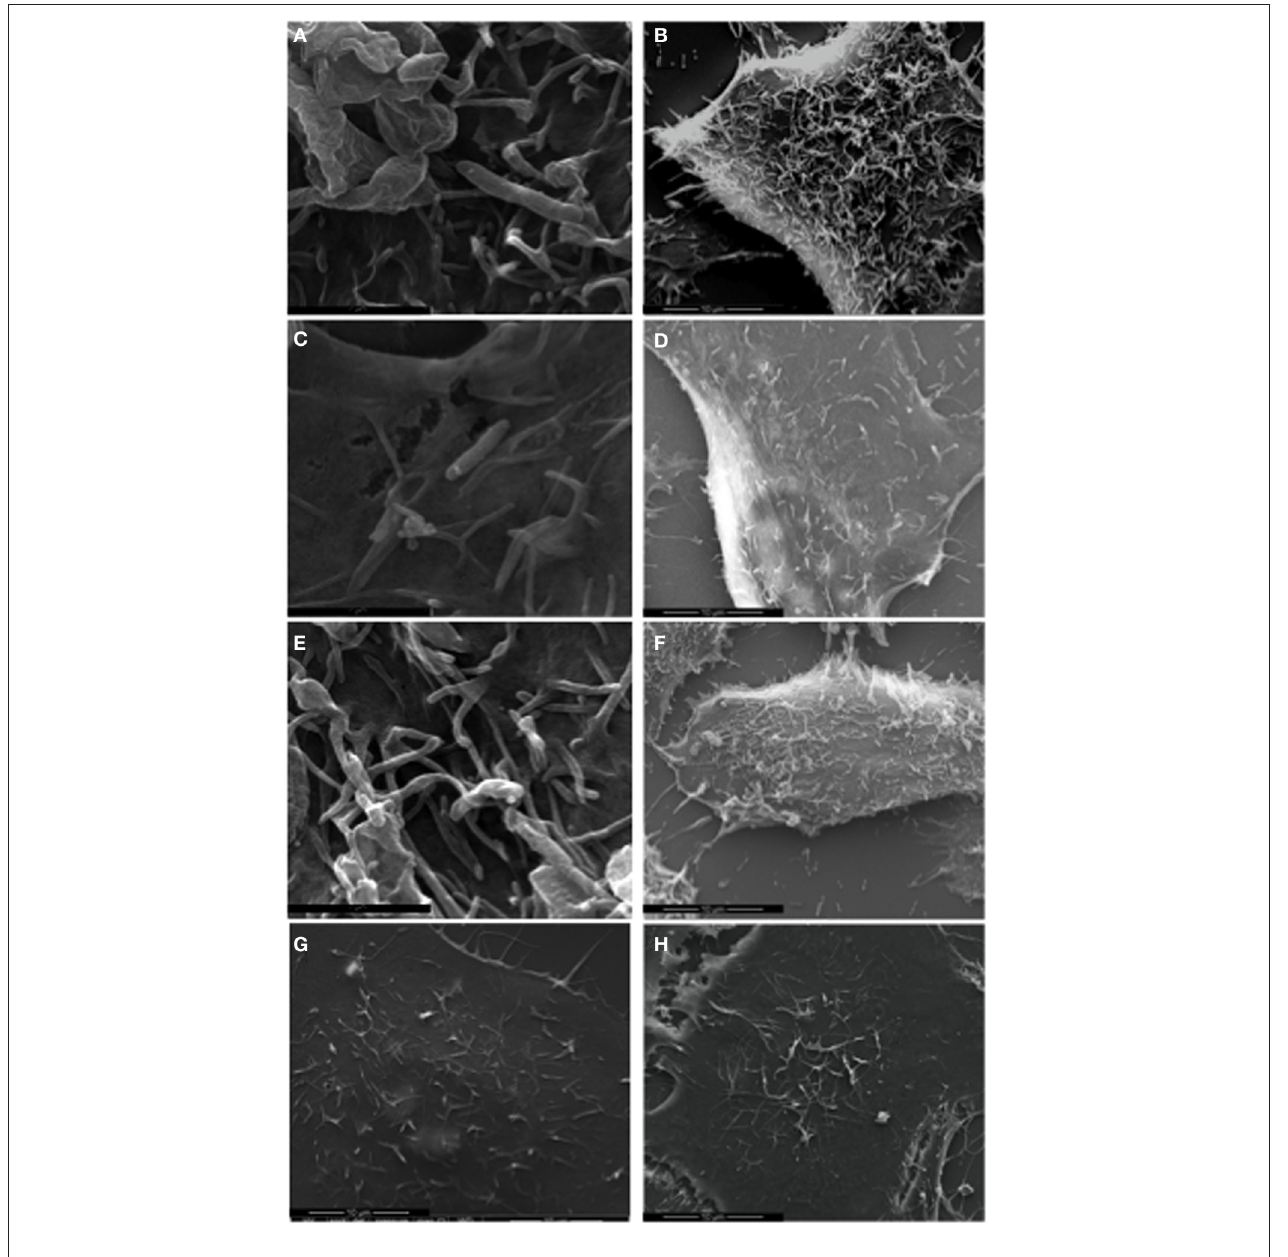
the Cia proteins (G) , or were uninfected (H) . The cells were fixed and removed at 15min post-infection, and visualized by SEM at 50,000 × (A, C, and E) and 7000 × (B, D, F, G, and H)